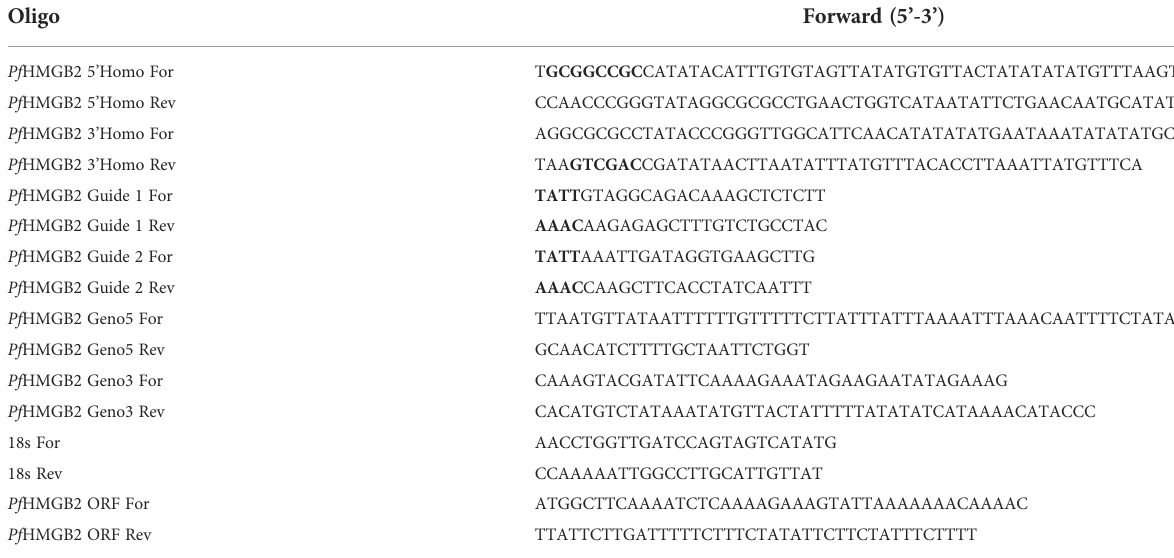
TABLE 1 Oligonucleotides used in the study. Oligonucleotides used for generation of Pfhmgb2¯ parasites Oligo